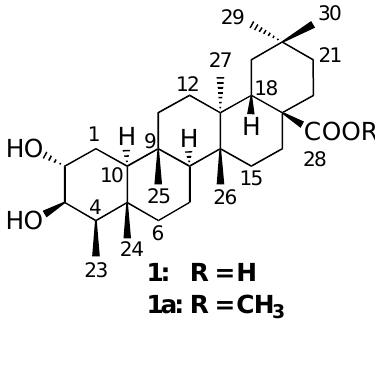
Figure 1 . Structures of compound 1 and 1a